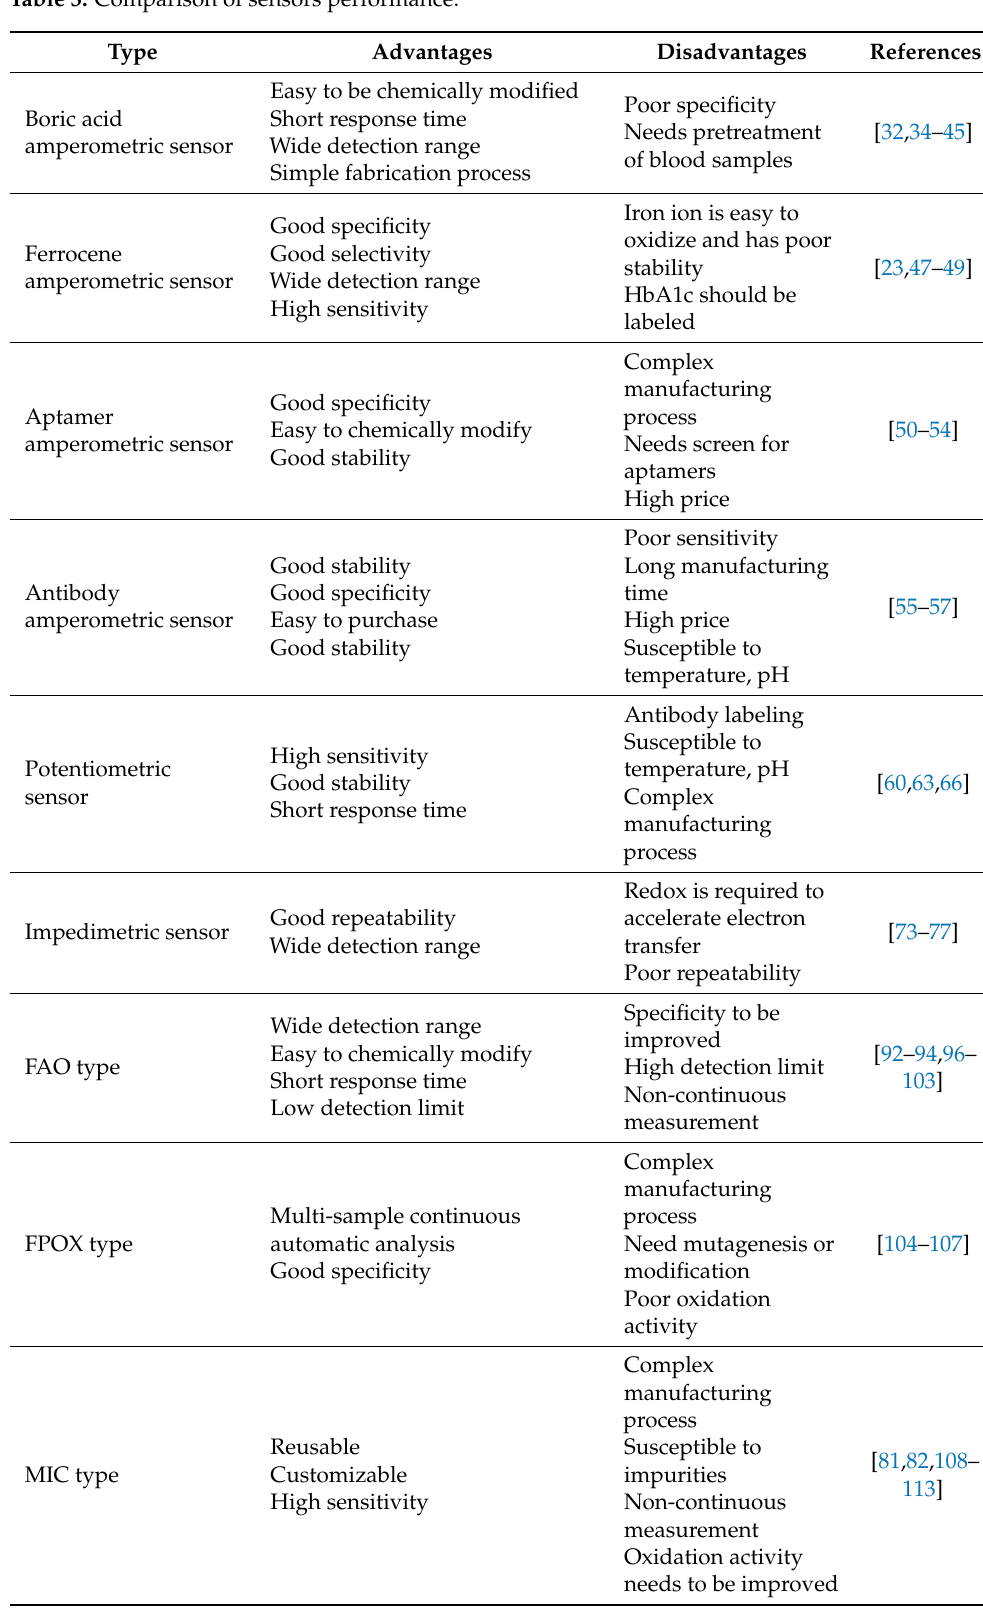
Table 3. Comparison of sensors